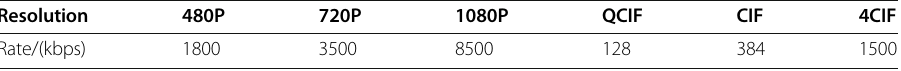
Table 4 Common video and image resolution and optimal transmission rate. The resolutions of several common videos and images and their corresponding optimal transmission rate Resolution 480P 720P